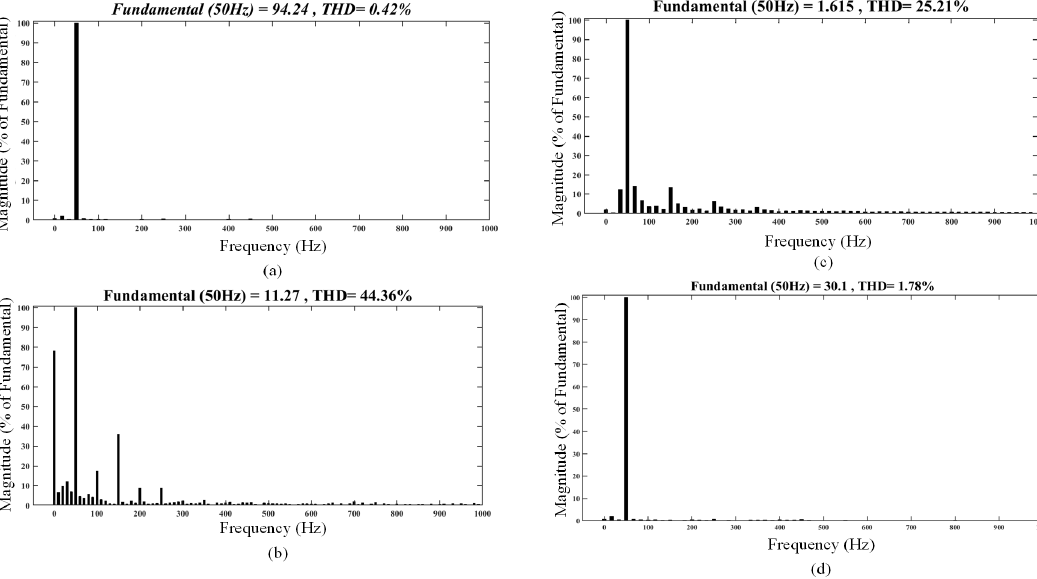
Figure 13. Harmonic spectrum: ( a ) Normal operation, ( b ) open-circuit fault, ( c ) short-circuit fault, and ( d ) FTC